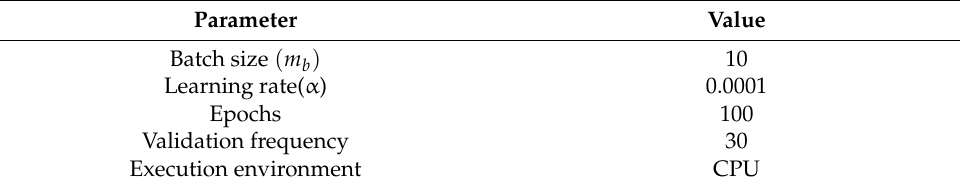
Table 1. CNN configuration parameters.